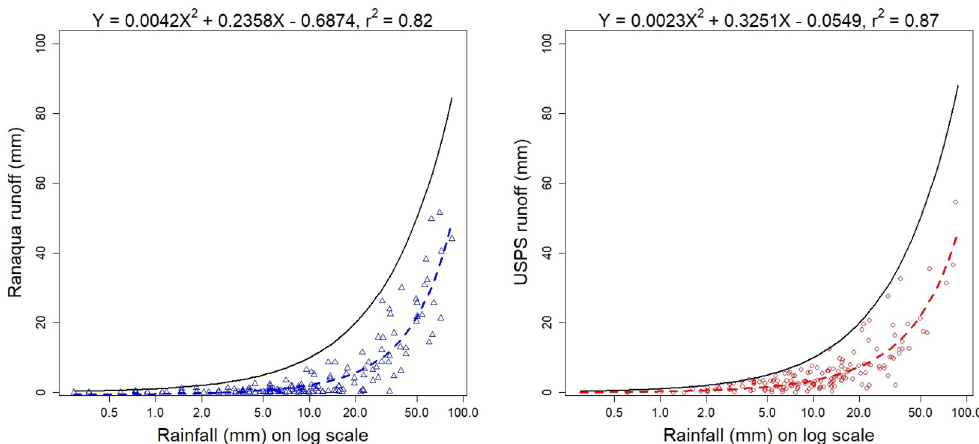
Fig 5. Rainfall versus runoff depths monitored between November 1, 2013 and December 31, 2017 for all storms with non-zero runoff. Characteristic Runoff Equations (CREs) are drawn as dotted lines for the green roofs ( a ) Ranaqua; ( b ) USPS. The black solid curves denote 1:1 agreement, representing hypothetical roofs where all rainfall becomes